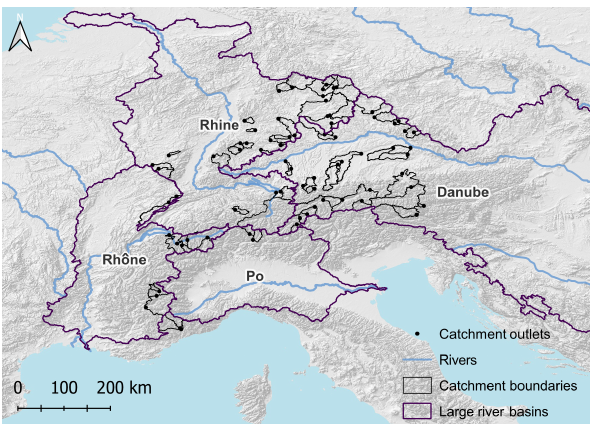
Figure 1. A total of 74 catchments in the central Alps with at least 10 years of streamflow data before and after reservoir construction (black catchment